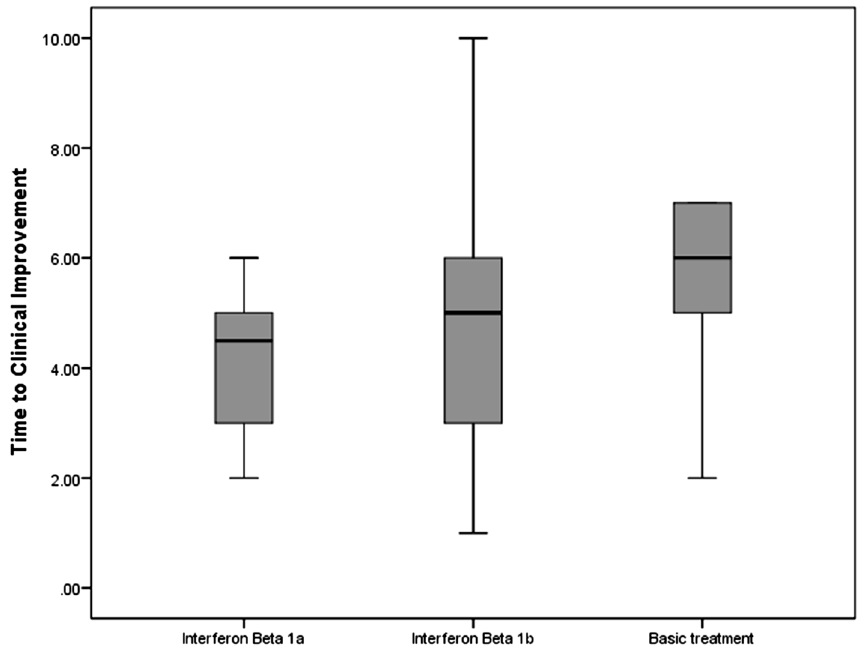
Figure 2. Box-plots of time to clinical improvement across three treatment groups for those patients who reached the improvement (The patients who experienced mortality were omitted from this box-plots).